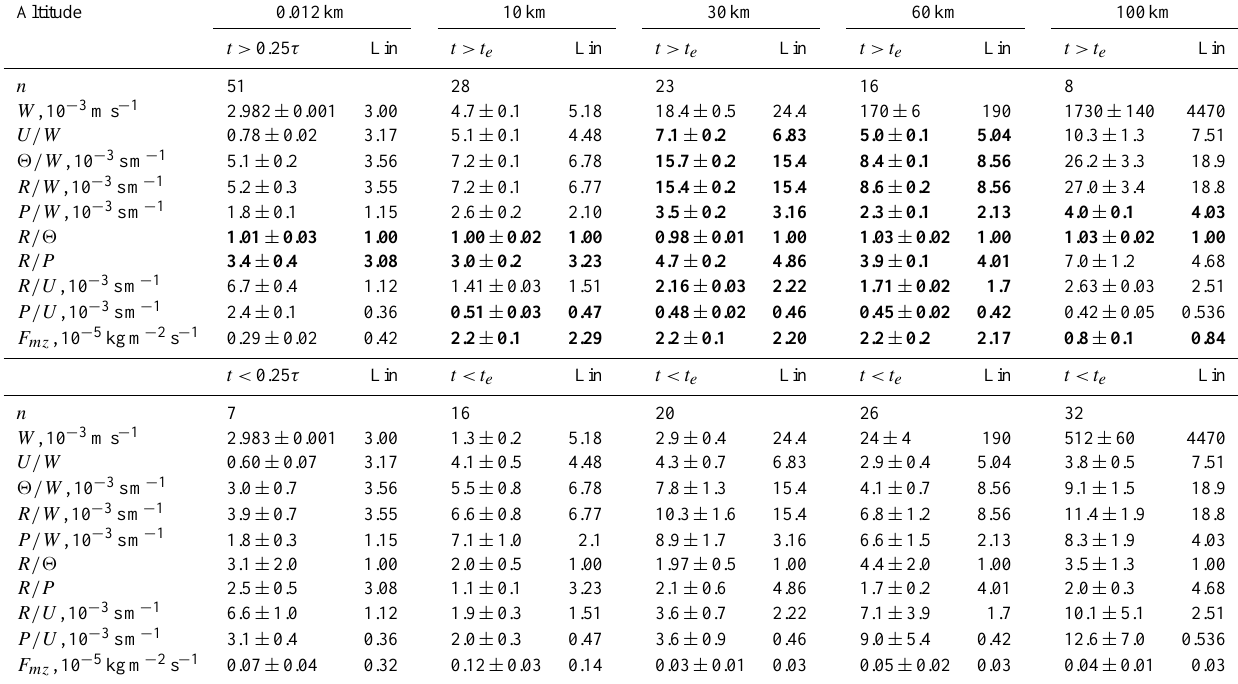
Table 1. Standard deviations and their ratios for AGW with c x = 30ms − 1 calculated with the numerical model and with analytical polar- ization relations (labeled as Lin) at different altitudes averaged over the initial transient interval t <t e and for quasi-stationary waves t >t e . Bold font shows the data pairs equal to probabilities larger than